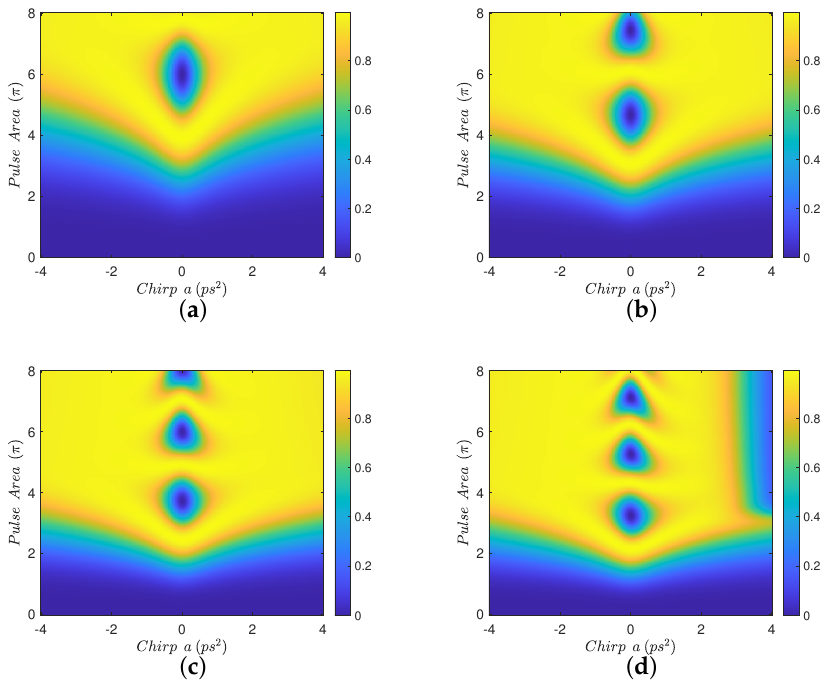
Figure 3. Contour diagrams for the biexciton population at the final time, as function of the pulse area and the chirp parameter a of the applied Gaussian pulse, with biexciton energy shift E b = − 10 meV and four different interparticle distances: ( a ) R = 100 nm, ( b ) R = 15 nm, ( c ) R = 12 nm, and ( d ) R = 11 nm.